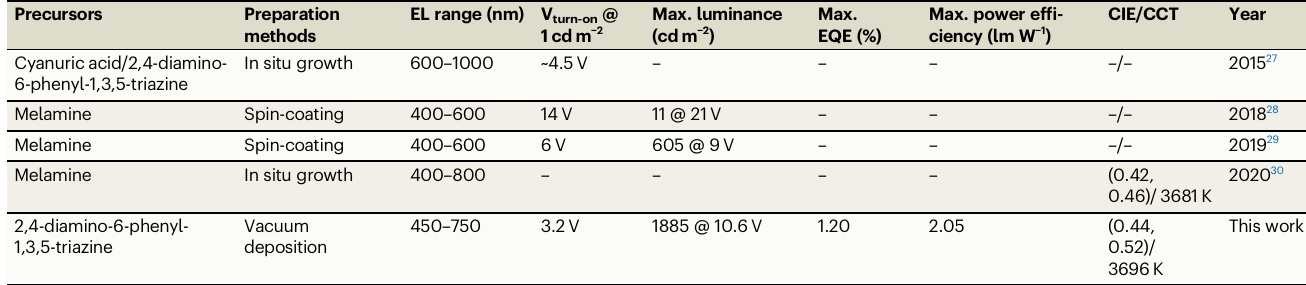
Table 1 | Summary of the performance of g-CN-based LEDs devices